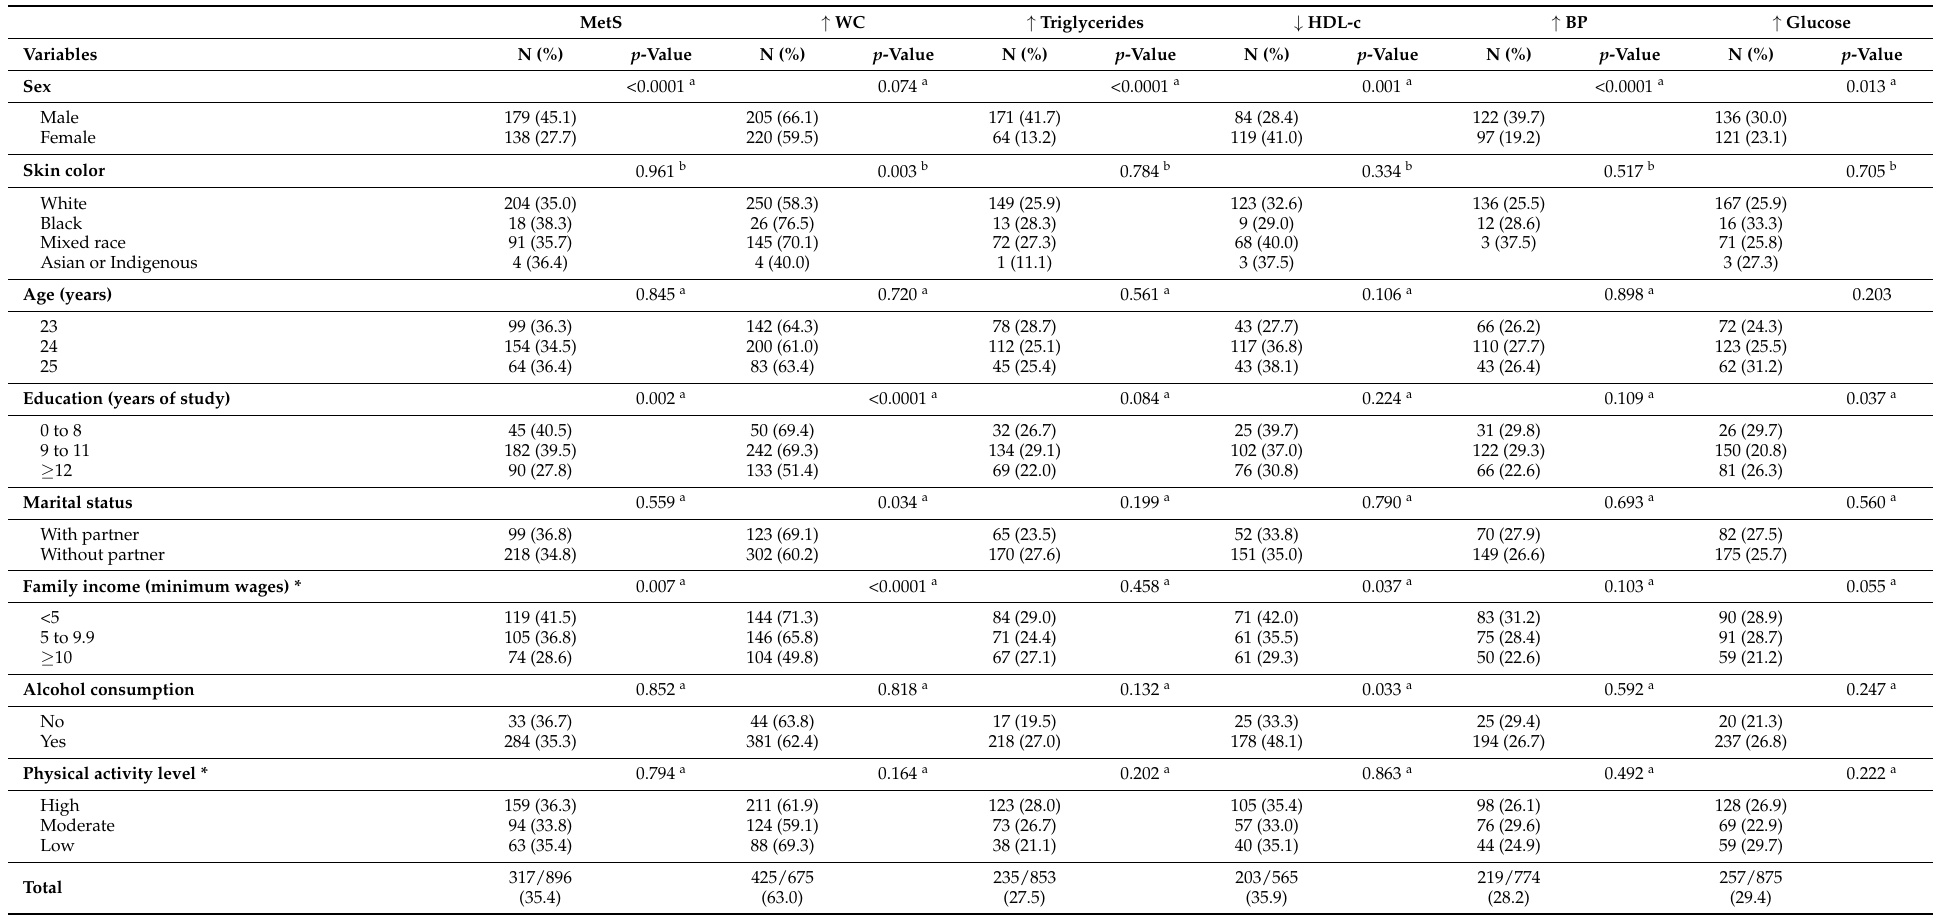
Table 2. Incidence of metabolic syndrome and its components at 37–39 years according to demographic, socioeconomic and lifestyle characteristics of the